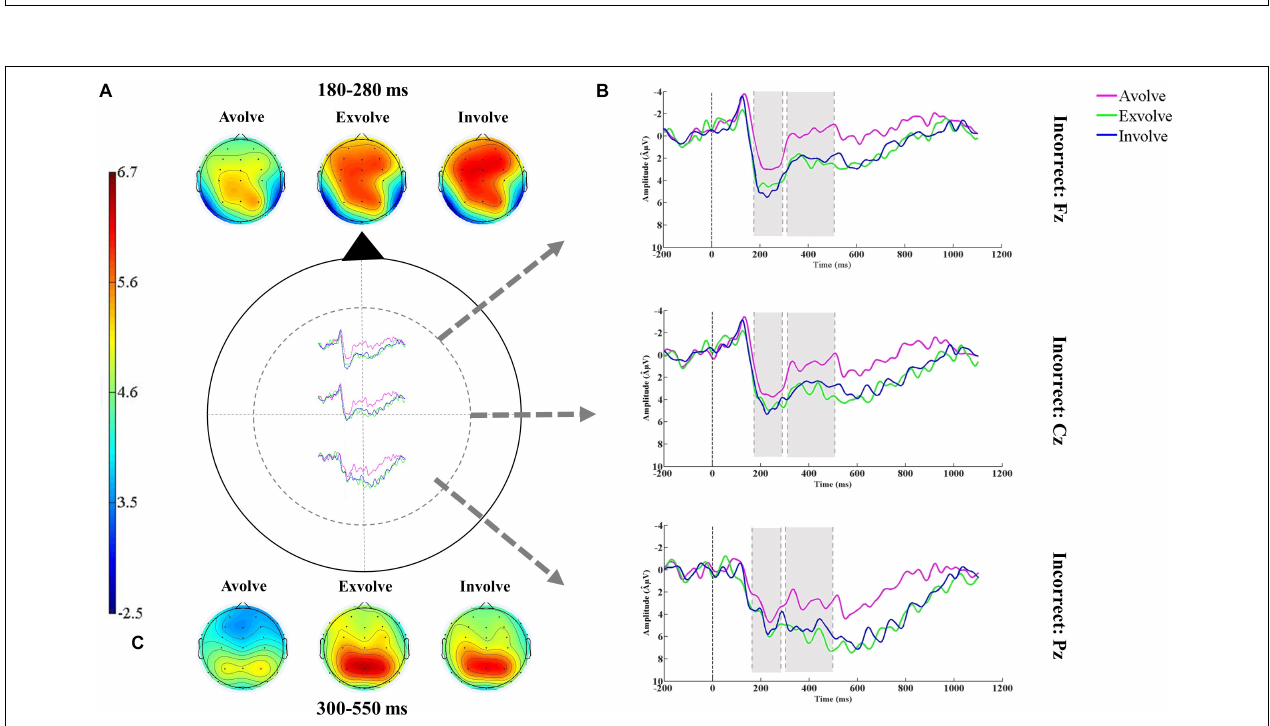
FIGURE 4 | (A) Grand-average ERPs ( N = 18) elicited by the correct condition in response to different combinations of senses (i.e., avolvement, exvolvement, and involvement. (B) The topographic maps plotted in the latency window of 180–280 ms after the stimulus onset. (C) The topographic maps plotted in the latency window of 300–550 ms after the stimulus onset.